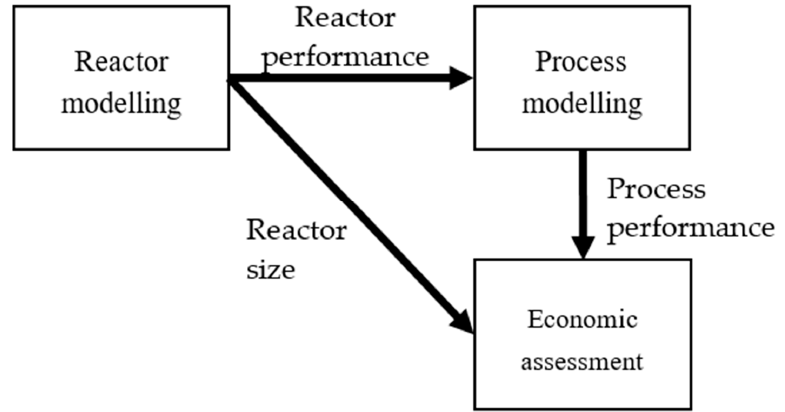
ff erent parts of the present